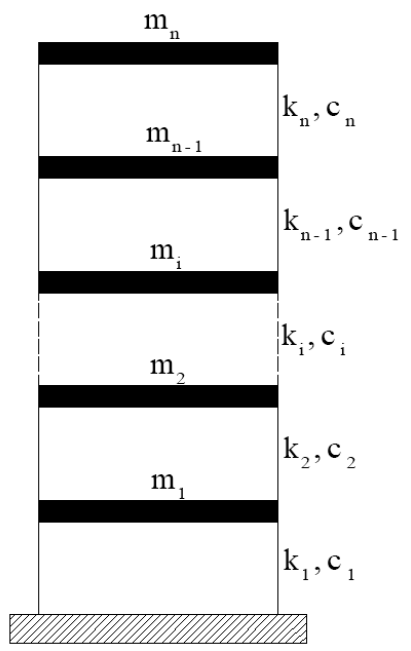
Figure 1. Fixed ‐ based shear building. Figure 1. Fixed-based shear